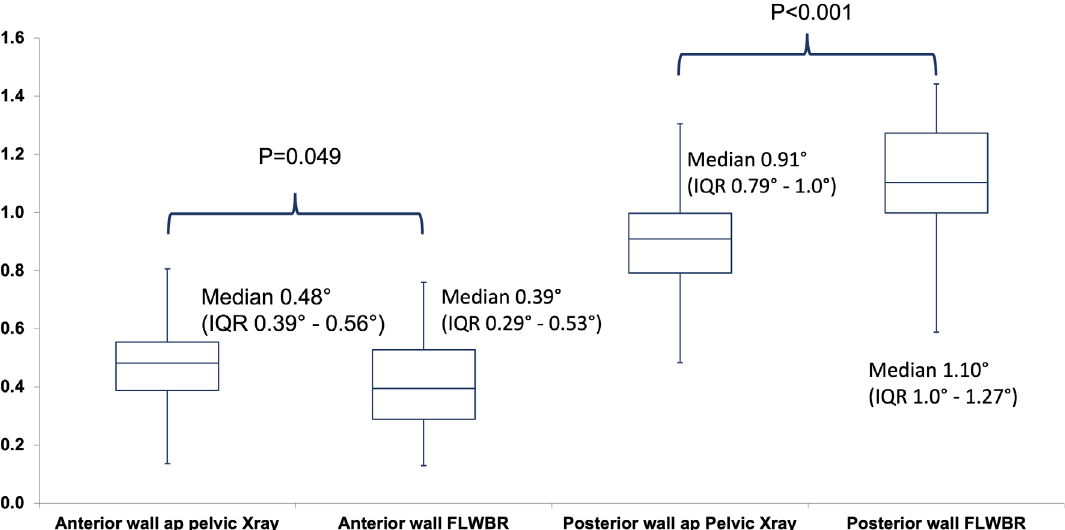
Figure 3. Box plot depicting anterior and posterior wall coverage measured on conventional ap pelvic radiographs and full-length weight- bearing